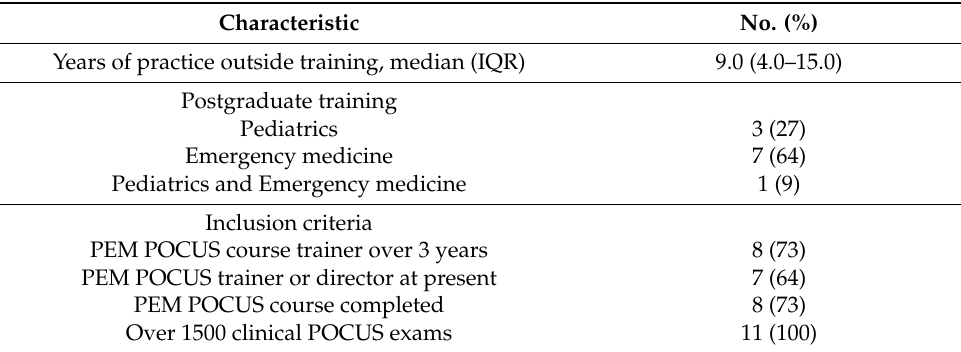
Table 1. Profile of Expert Respondents Completing Round 1 ( n = 11).